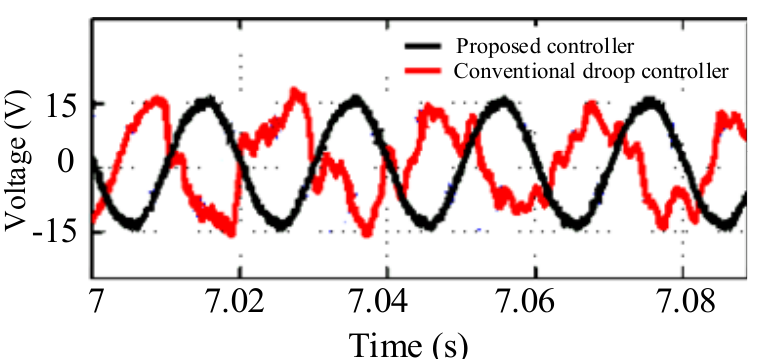
Figure 20. Comparison of output voltage changes in the first scenario using the conventional droop controller and the proposed controller.